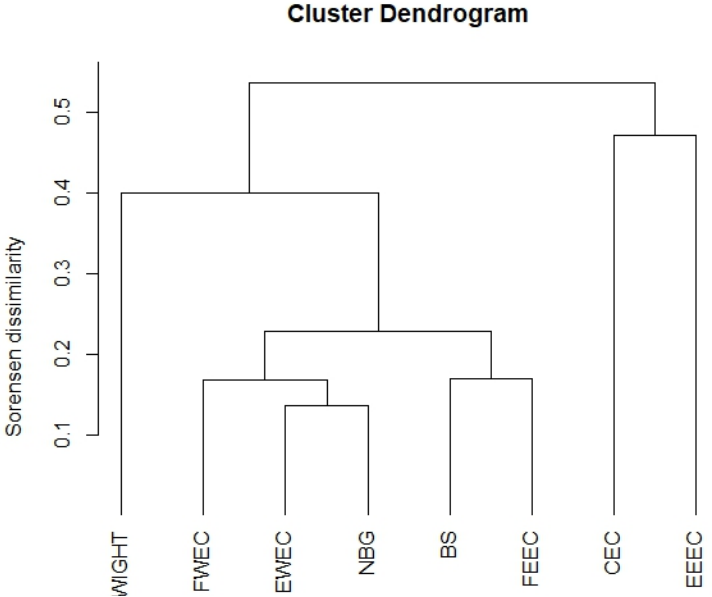
Figure 3. Results of cluster analysis (Sørensen similarity) on the species presence and absence (269 species) in the eight zones of the English Channel: FWEC: French side of Western English Channel; EWEC; English side of Western English Channel; NBG: Normano-Breton Gulf; BS: Bay of Seine; CEC: Central English Channel; Wight; FEEC: French side of Eastern English Channel; EEEC: English side of Eastern English Channel.